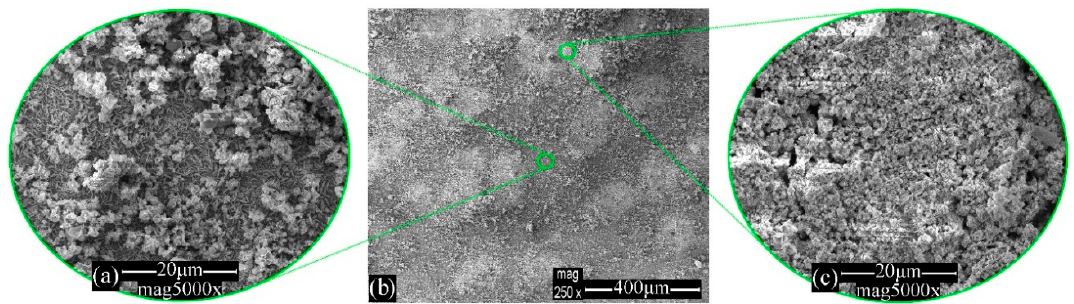
Figure 3. SEM images of mild steel immersed in WSS for 96 h in the absence of inhibitors.